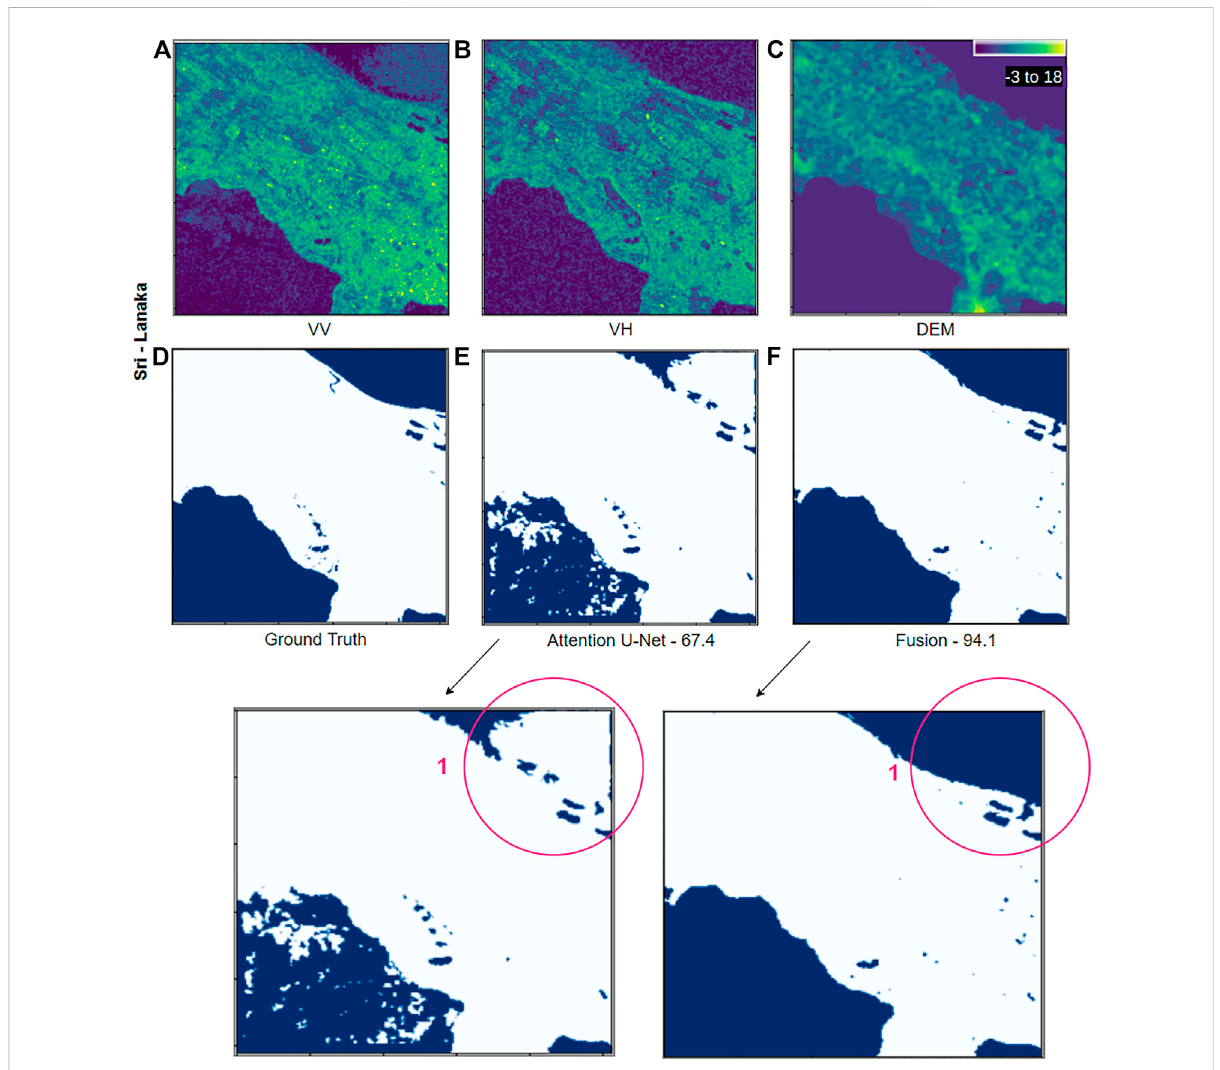
FIGURE 6 Detection result samples from the Spain site. In visualization contains (A) VV, (B) VH, (C) DEM, (D) ground truth, (E) attentive U-Net network prediction and (F) Fusion network prediction. Third row contains zoomed version of (E) and (F) . The red circles highlight the areas described in the text. The numbers speci fi ed under the prediction maps are the corresponding IoU